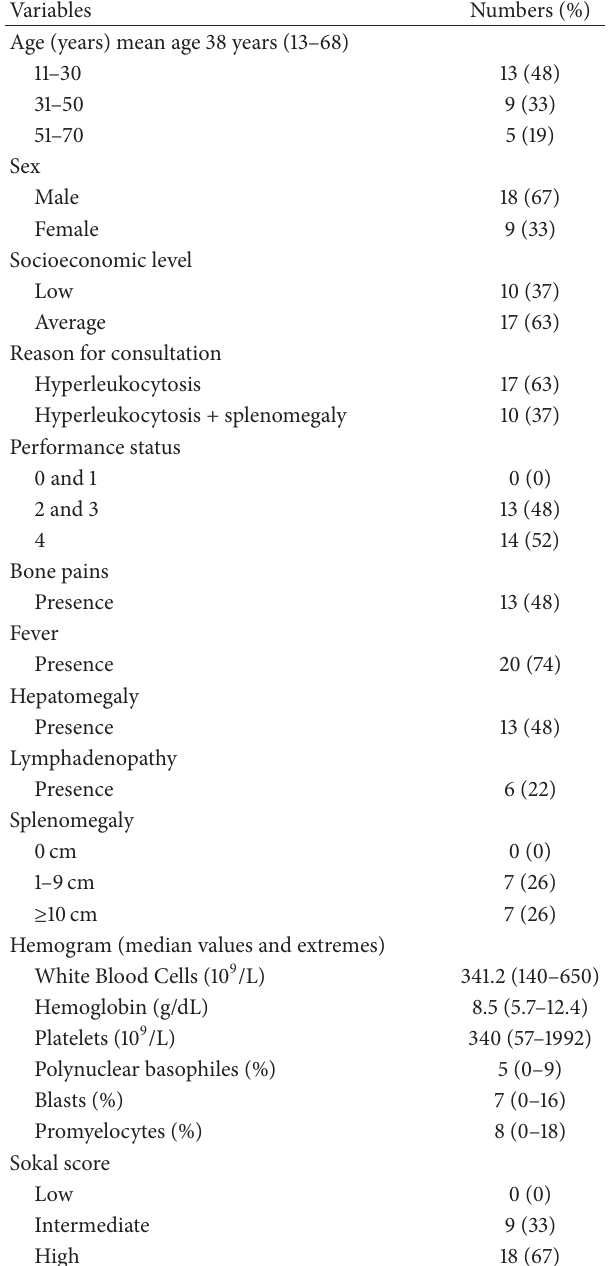
Table 1: Epidemiological, clinical, and biological features of